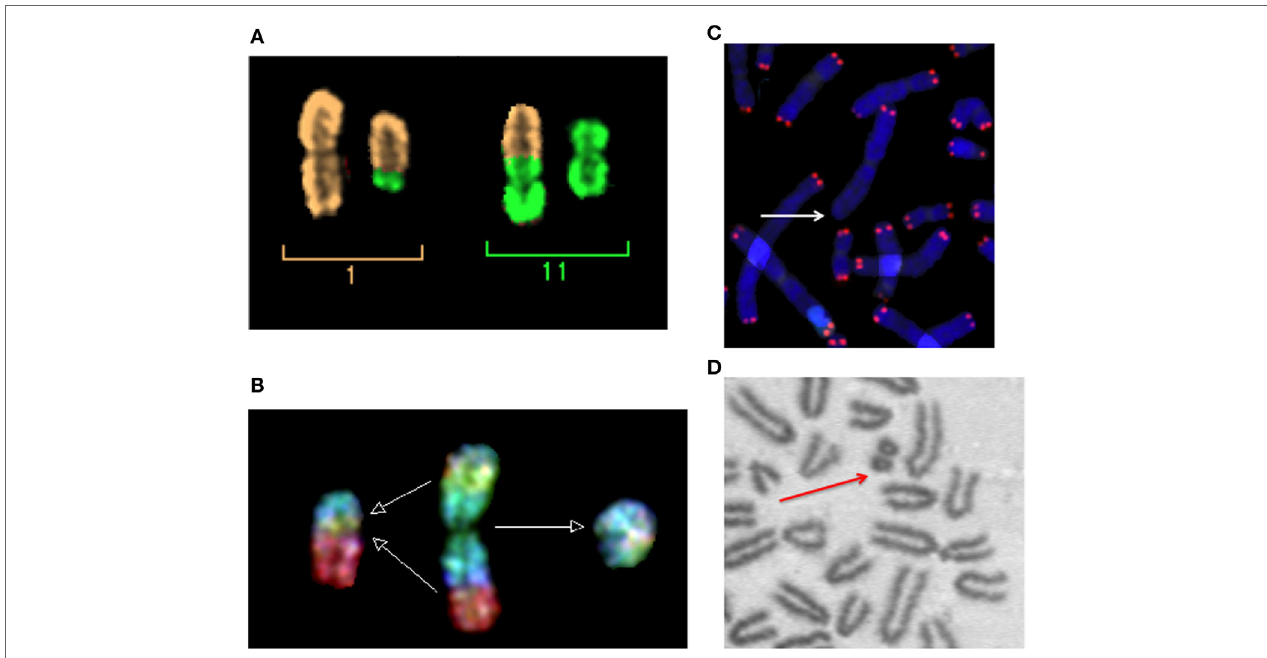
FiGURe 2 | Micronuclei originate from radiation-induced chromosome aberrations. Acentric fragments in irradiated cells are shown in this panel. (A) A dicentric chromosome and associated acentric fragment between chromosome 1 and 11 in a human peripheral blood lymphocytes exposed to heavy ions. Image visualized by mFISH. (B) Formation of a radiation-induced ring and its associated acentric fragment visualized by R × FISH (cross-species color banding). A normal chromosome 3 is shown in the middle, the centric ring on the right, and the acentric fragment resulting from the joining of the two residual fragments in the two different arms on the left. (C) A terminal deletion induced by heavy ions in human lymphocytes. The lack of telomere signal indicates that a fragment has been lost. (D) An interstitial deletion at the first mitosis following exposure of G0-phase mouse fibroblasts to X-rays. Interstitial deletions appear often as double minutes. In this photomicrograph of Giemsa-stained mitotic chromosomes, it is clear their nature of acentric rings resulting from the asymmetrical intra-arm